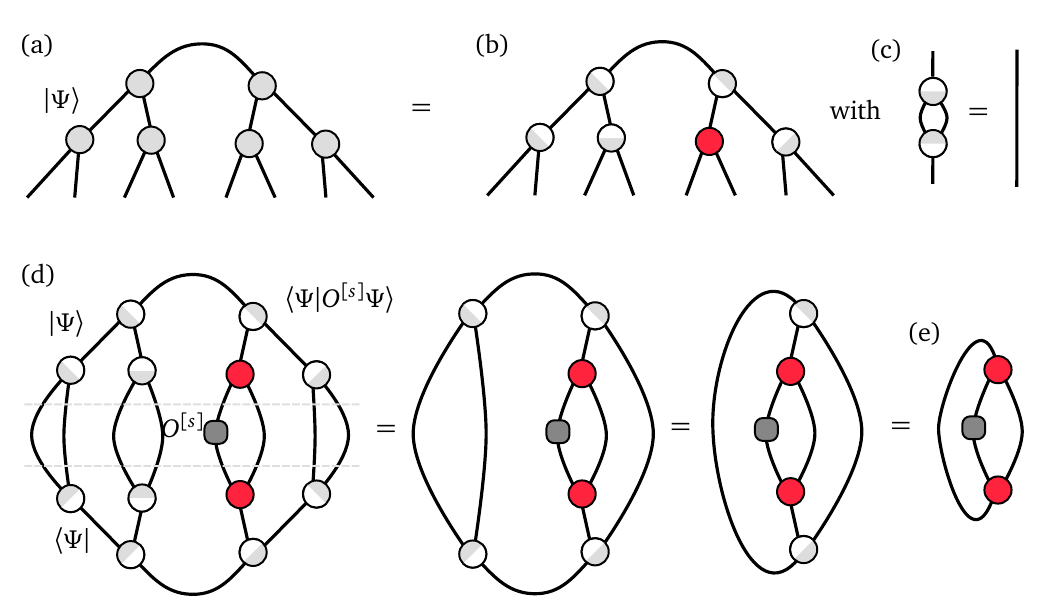
Figure 25: (a) A binary tree TN as an example of a loop-free TN describing some QMB state | Ψ 〉 : Writing it in a certain gauge (b) imposes certain rules (c) on the network. Knowledge about the gauge then allows us to simplify the numerical calculations, here the calculation of the expectation value of some local observable 〈 Ψ | O [ s ] | Ψ 〉 . The bra TN is drawn as the vertically flipped version of the ket TN, indicating hermitian conjugation of all its tensors (d): By applying the rules, we see that most contractions (which would be necessary in a network without a gauge) do not have to be performed explicitly numerically. We are left with a much simpler network (e) where only the contractions that cannot be “annihilated” using gauge rules have to be